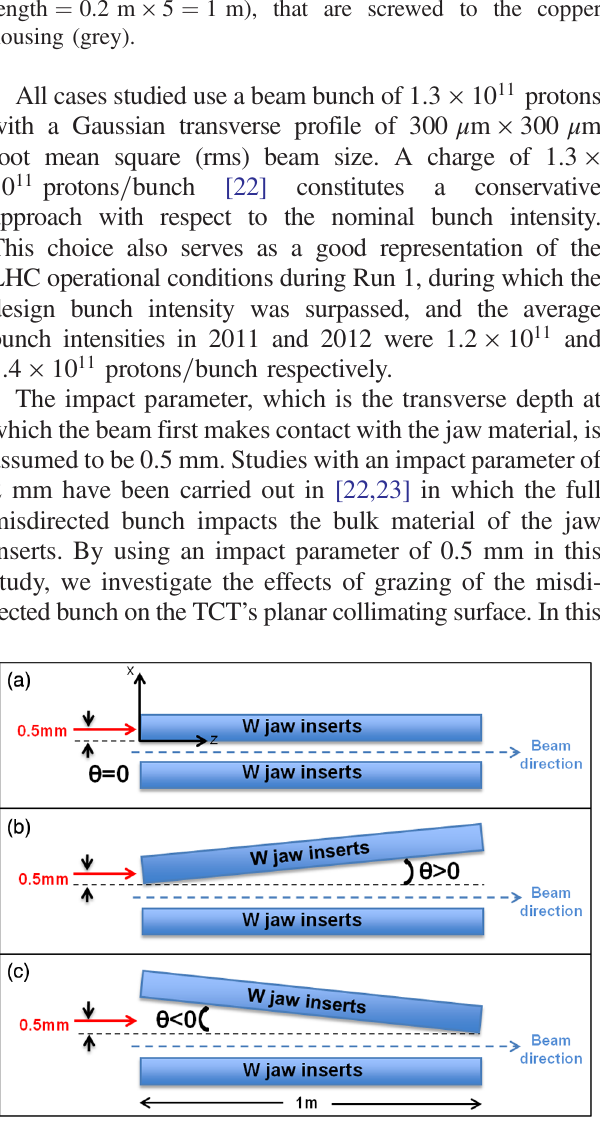
FIG. 6. Schematic diagrams (not to scale) of the studied jaw error cases: an ideal case in which the collimator jaws are perfectly aligned with respect to the beam direction ( θ ¼ 0 ) (a), and cases with a tilt ( θ > 0 , θ < 0 ) of one collimator jaw due to misalignment errors (b) and (c). Each blue bar comprises five W inserts, where the dimensions of each insert are 20 mm ð x Þ × 34 mm ð y Þ × 200 mm ð z Þ , while the considered beam impact parameter is 0.5 mm in the x direction. The sign of the tilt angle is shown, and the dashed black line refers to the collimator position in design orbit.